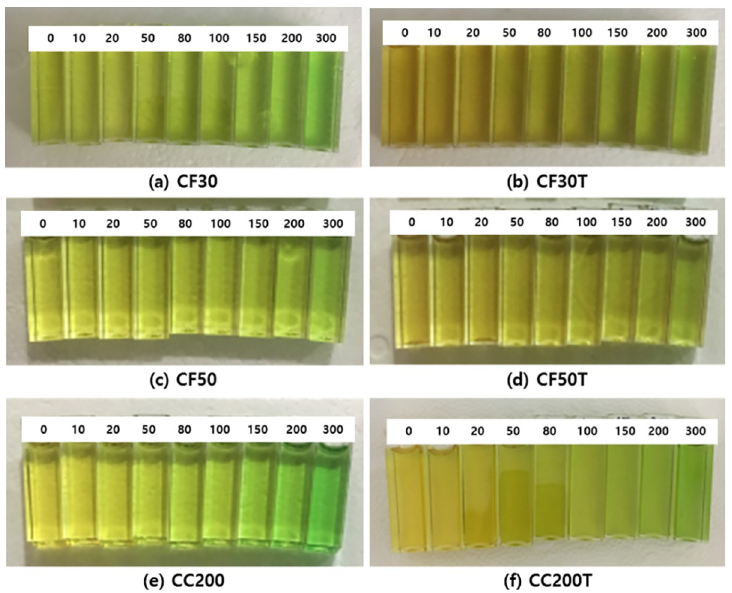
Fig 2. Representative photographs of the fabricated dosimeter cuvettes with different polyurethanes incorporating tartrazine. (a) The CF30 formulation refers to polyurethane Clear Flex ™ 30 without tartrazine, (b) the CF30T formulation refers to polyurethane Clear Flex ™ 30 with tartrazine, (c) the CF50 formulation refers to polyurethane Clear Flex ™ 50 without tartrazine, (d) the CF50T formulation refers to polyurethane Clear Flex ™ 50 with tartrazine, (e) the CC200 formulation refers to polyurethane Crystal Clear ™ 200 without tartrazine, and (f) the CC200T formulation refers to polyurethane Crystal Clear ™ 200 with tartrazine. Each cuvette was irradiated with various doses (0, 10, 20, 50, 80, 100, 150, 200, and 300